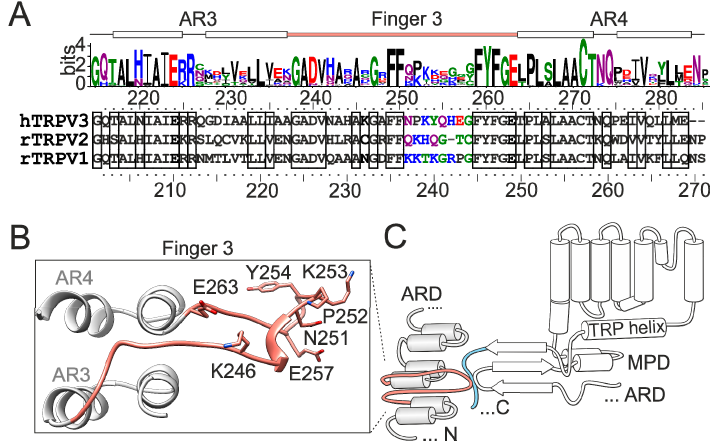
Figure 1. Schematic representation of the finger 3 loop region of transient receptor potential vanilloid 3-ankyrin repeat domain (TRPV3-ARD). ( A ) Sequence logo along thermally activated TRPV channels (fish, frog, snake, chicken, mouse, rat, and human TRPV1-4) and amino acid alignment of human TRPV3, rat TRPV2, and rat TRPV1 with elements of secondary structure indicated above. Positions are numbered according to human TRPV3 (above) and rat TRPV1 (below). The residues of the tip of the finger 3 are indicated in colors. ( B ) Residues within the finger 3 mutated in this study shown in the context of ankyrin repeats 3 and 4 (AR3 and AR4) of the mouse TRPV3 structure (Protein Data Bank Code 6DVW). ( C ) Topology diagram of TRPV3 N-terminal finger 3 (salmon) positioned in close proximity of the loop from the ankyrin repeat domain-transmembrane domain (ARD-TM) linker region (red) and the C-terminal loop domain (light blue) of an adjacent subunit. MPD, membrane proximal domain. The sequence logo was generated via WebLogo3 server